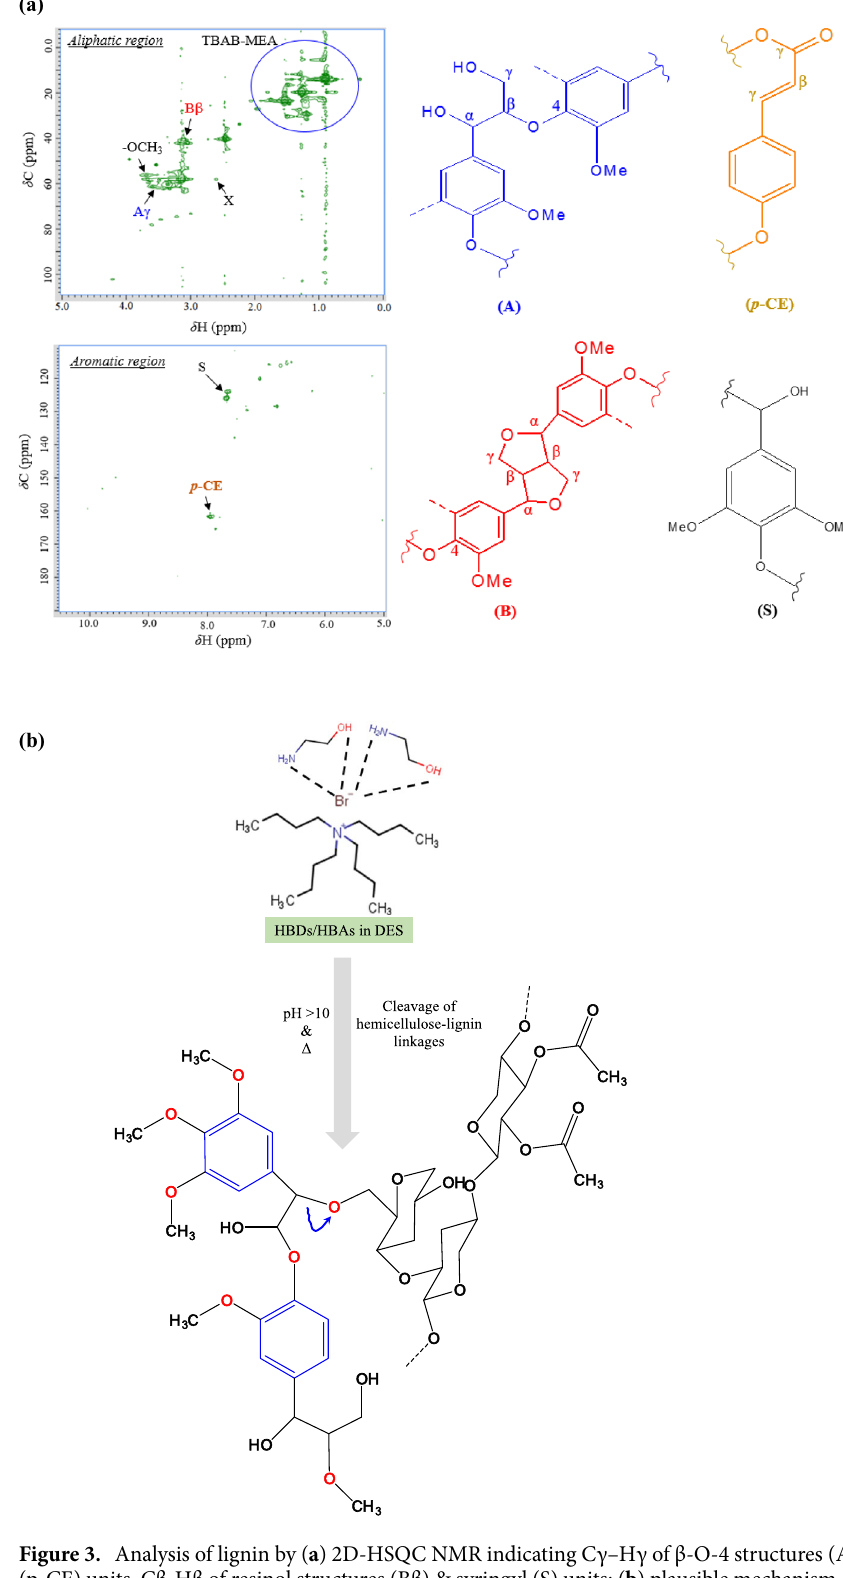
Figure 3. Analysis of lignin by ( a ) 2D-HSQC NMR indicating Cγ–Hγ of β-O-4 structures (Aγ), p-coumarate (p-CE) units, Cβ-Hβ of resinol structures (Bβ) & syringyl (S) units; ( b ) plausible mechanism of xylan and lignin cleavage catalyzed by DES solvent